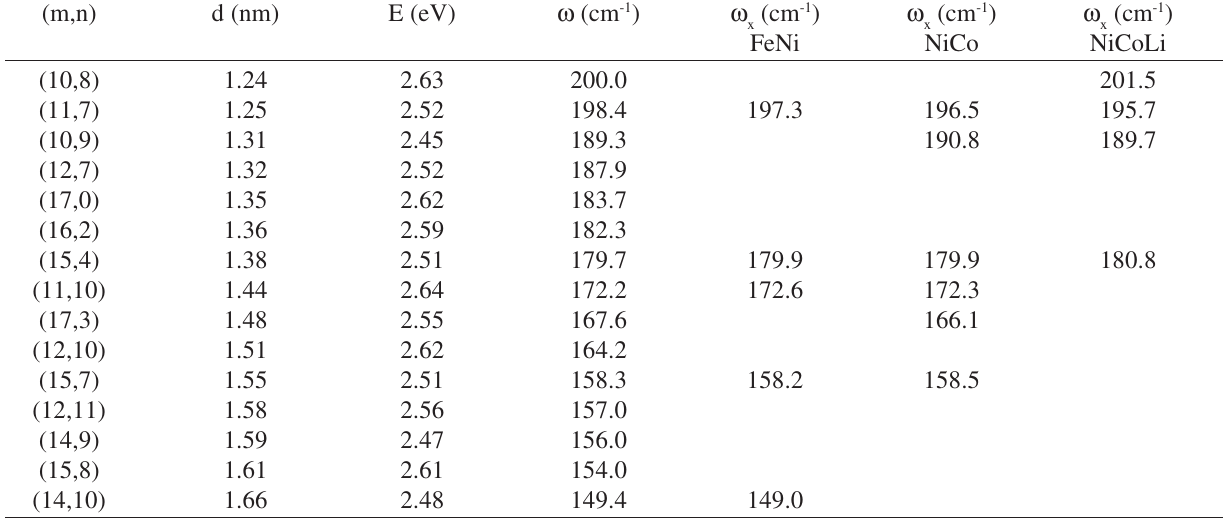
Table 1. Chiralities for nanotubes, calculated diameter, d, resonant energy, 2.44 eV < E < 2.64 eV, calculated frequency, ω , and Raman frequencies, ω . Here, ω = α /d, with α = 248 cm -1 x